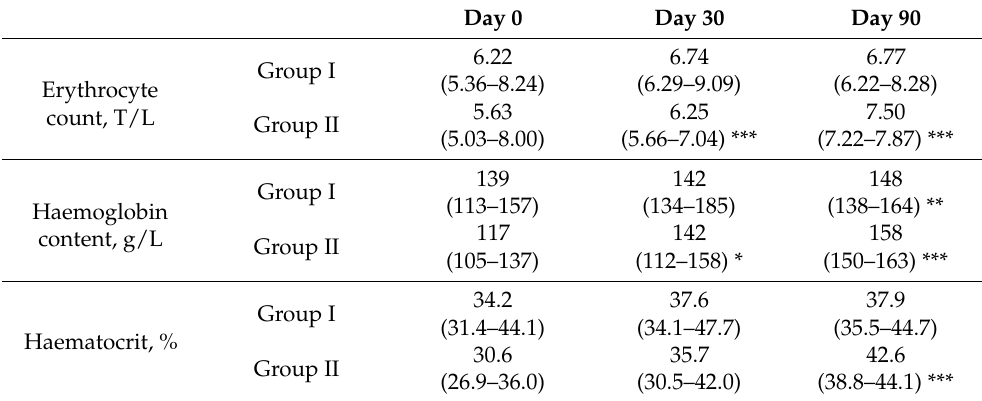
Table 1. Erythrocyte counts, haemoglobin content and haematocrit in rats from experimental groups I and II on day 0 ( n = 24), 30 ( n = 24) and 90 ( n = 12). Values are presented as median (minimum– maximum